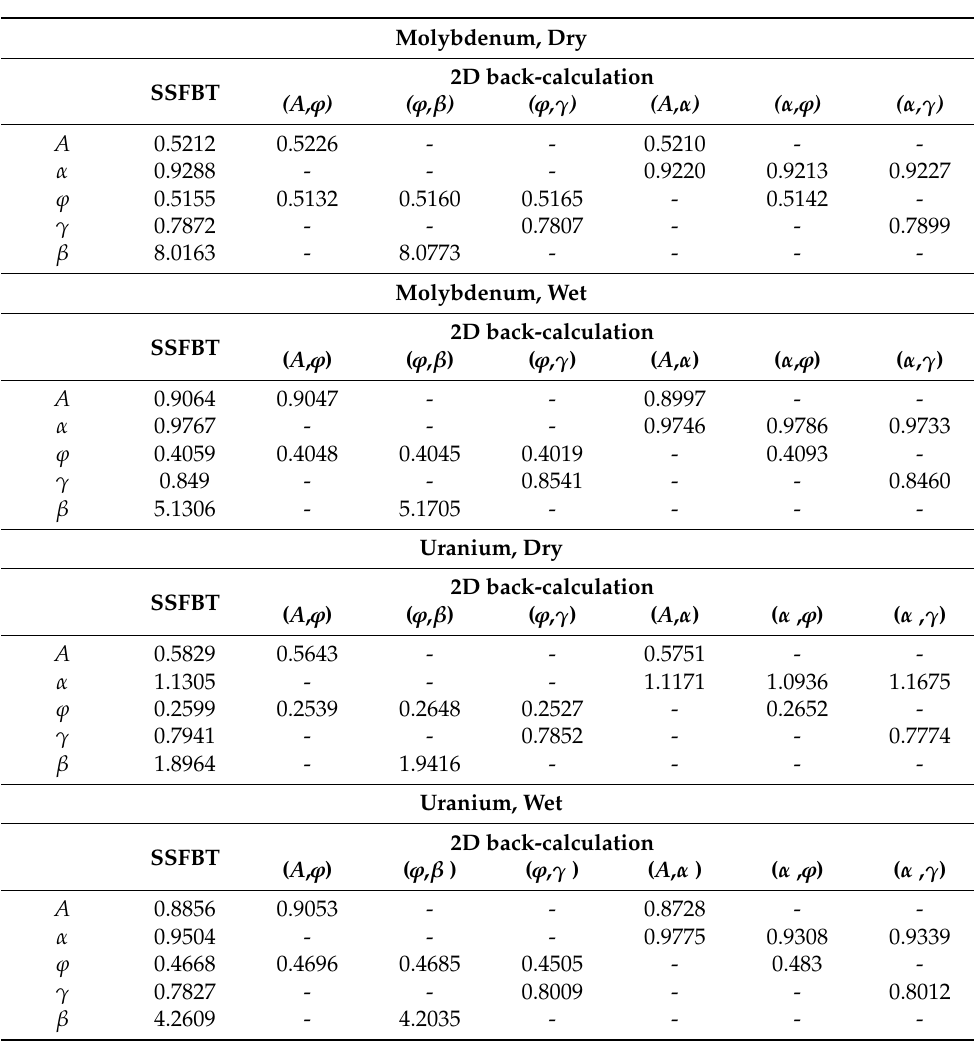
Table 3. Comparison between BFPs derived from SSFBTs and back-calculated values in the two- dimensional parameter space. The variables in parentheses refer to the back-calculated parameters, whereas other parameters remain fixed with the value from